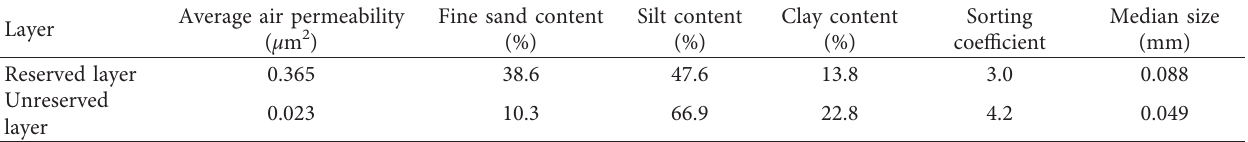
Table 5: WASP granularity analysis data from checking wells.